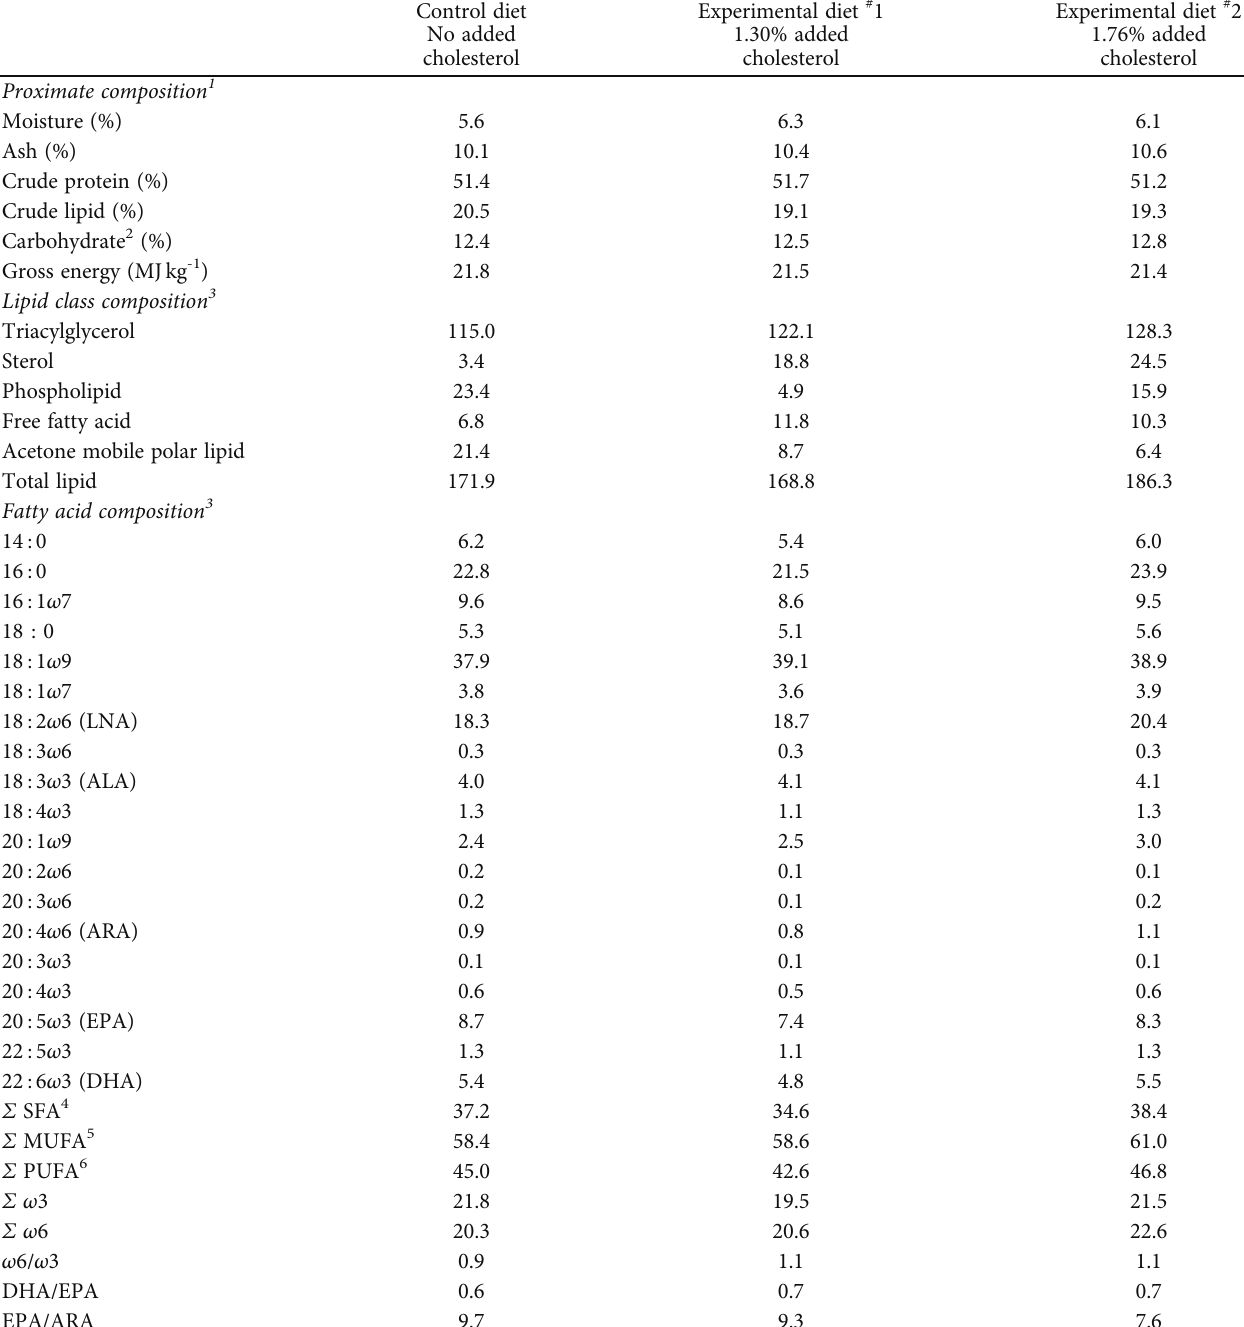
Table 2: Proximate, lipid class, and fatty acid composition of the experimental diets fed to the female triploid Atlantic salmon. Control